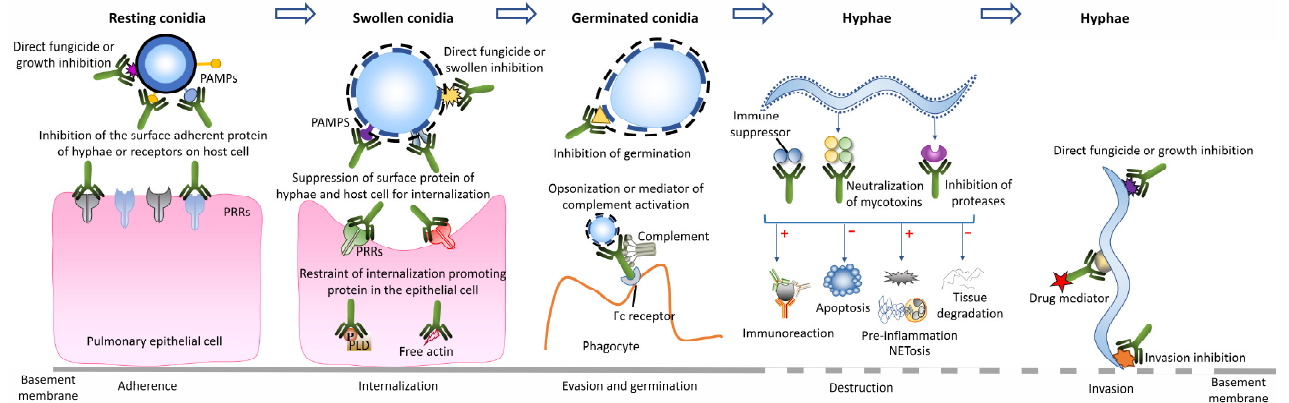
Figure 1. Monoclonal antibody-based modes to suppress or eliminate Aspergillus. The interference of monoclonal antibody in the process of adherence, internalization of Aspergillus conidia, or the process of germination, destruction and invasion of Aspergillus hyphae may be a potential treatment target to protect the host. Adapted from Lian X. et al. [23].